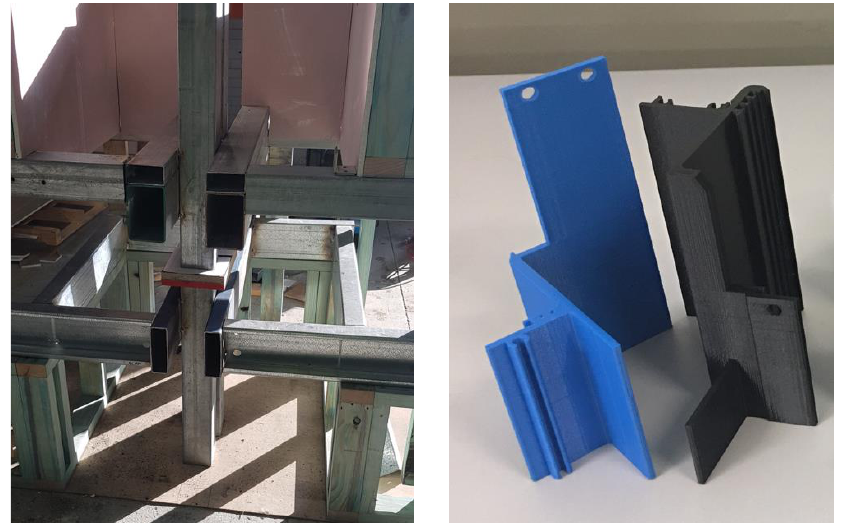
Figure 16. Example of a full-scale prototype carried out within the manufacturing facility of a prefab builder for a double storey-steel modular building to check issues in buildability and installation sequence.